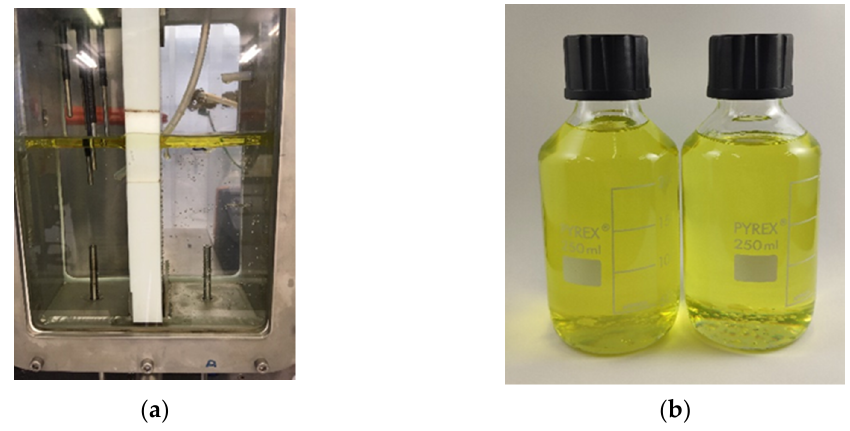
Figure 6. ( a ) The automated BTX and water phase separation system; ( b ) BTX final product.